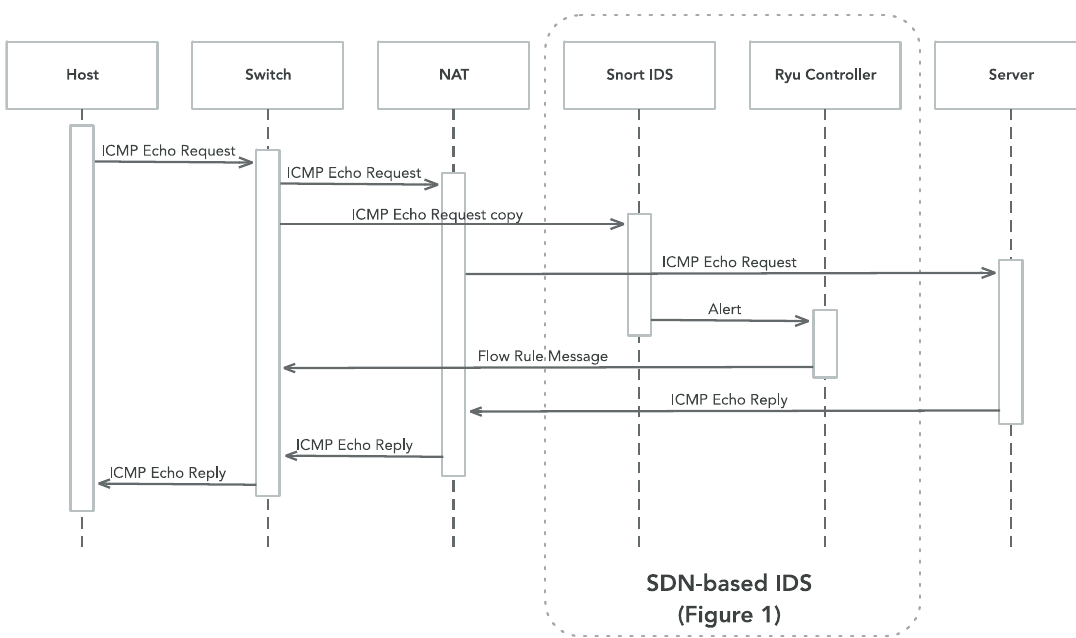
Figure 5. Sequential Diagram of System Messages.